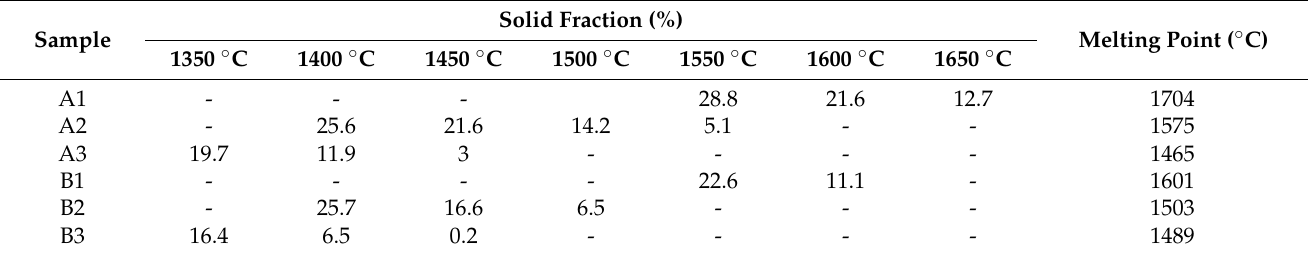
content (A2, A3, B2, and B3), the solid fraction decreased as FeO content increased. A1 and Table 2. The solid fraction and melting point of each sample simulated by Thermo-Calc software. Sample